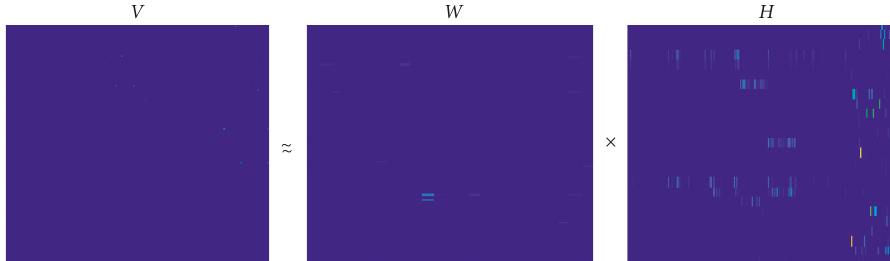
Figure 4: The NMF of the time-frequency